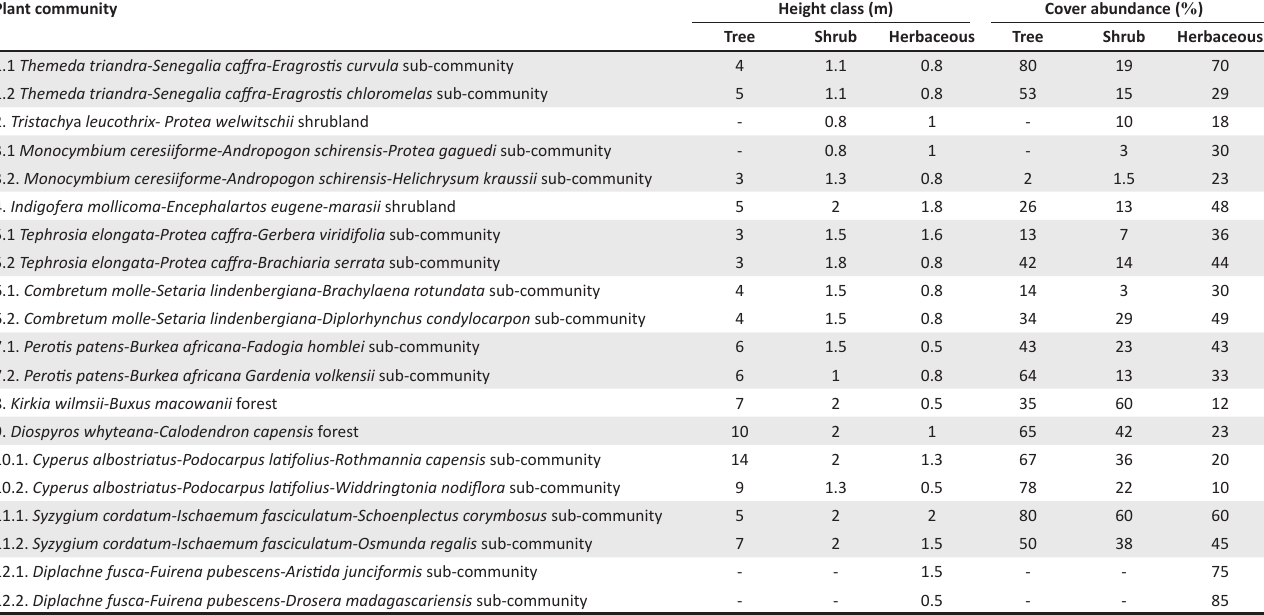
TABLE 2: Summary of the average height classes (m) and – cover abundance ( % ) relating to each plant community. Plant